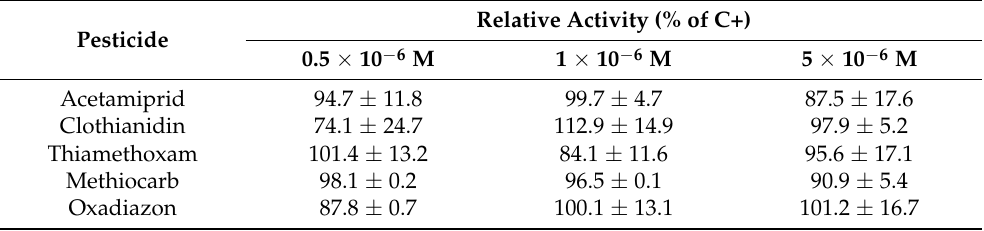
Table 1. Effect of pesticides on estrogen biosynthesis expressed as relative aromatase activity with respect to positive control (C+ = reaction without pesticide, relative aromatase activity of C+ = 100%). Data are presented as means ± standard